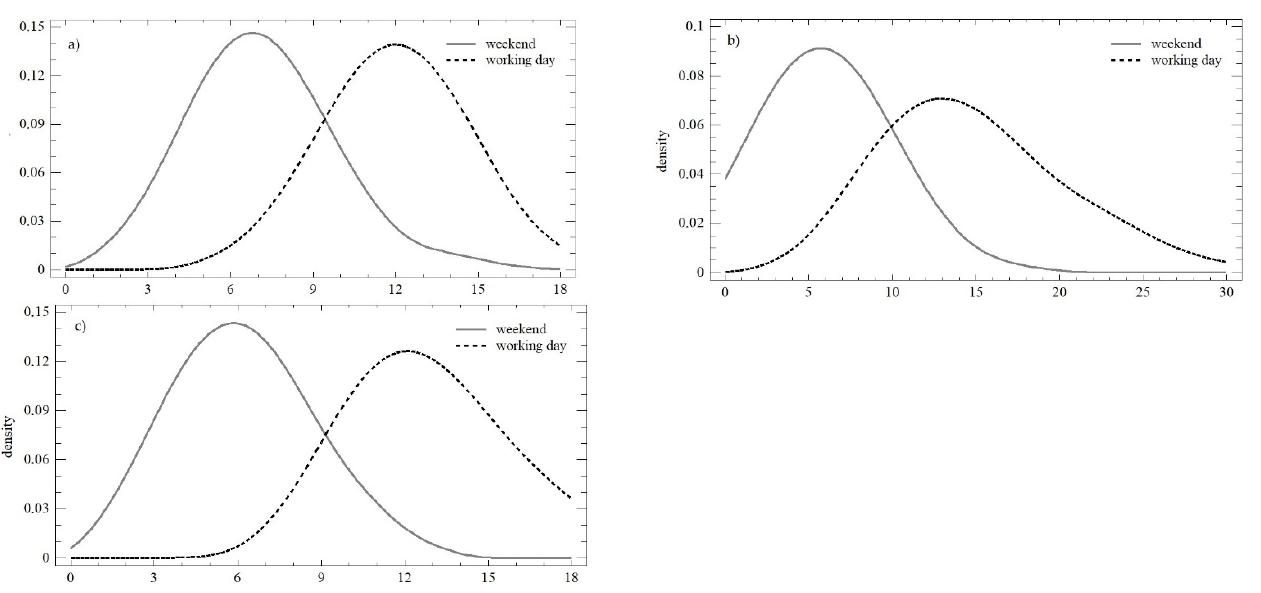
Figure 3. Density plot of the number of posts over the three monitored observation periods: ( a ) observation no. 1; ( b ) observation no. 2; ( c ) observation no. 3.